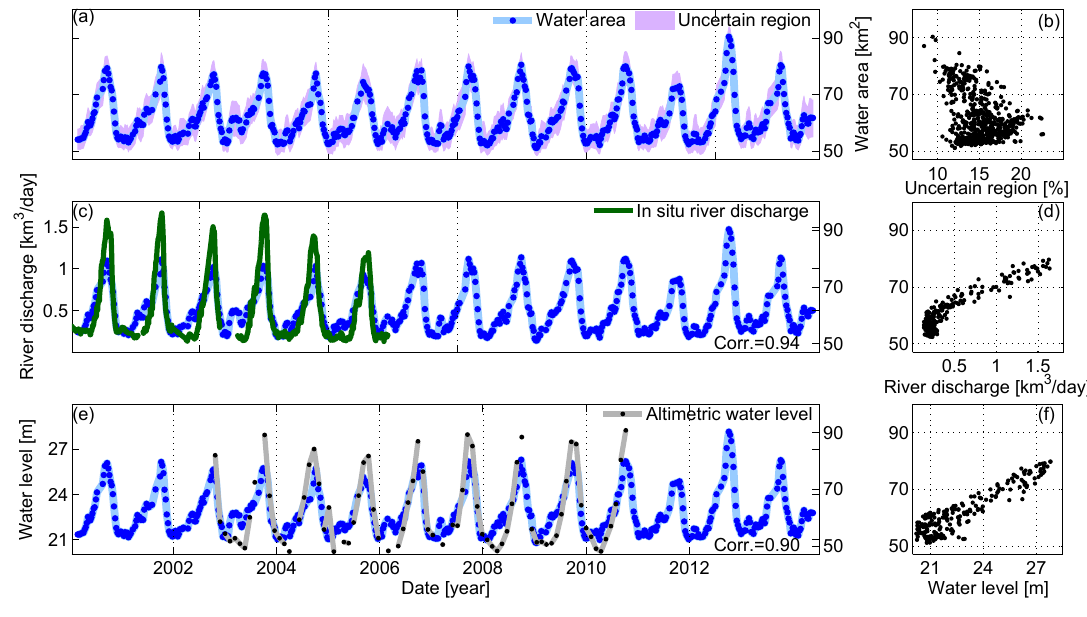
Figure 18. ( a ) Water area with its uncertainty; ( b ) Scatter plot of water area vs. percentage uncertainty; ( c , d ) Water area is plotted with in situ discharge and altimetric water level, respectively; ( e , f ) Scatter plots of simultaneous water area measurements against discharge and water level, respectively. Period of monitoring: February 2000–September